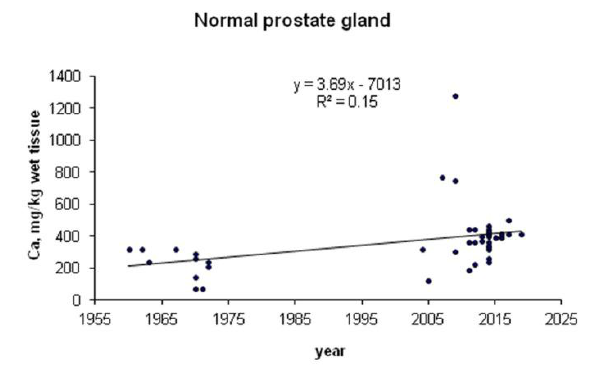
Figure 1 : Data on Ca content in “normal” prostate tissue reported from 1960 to